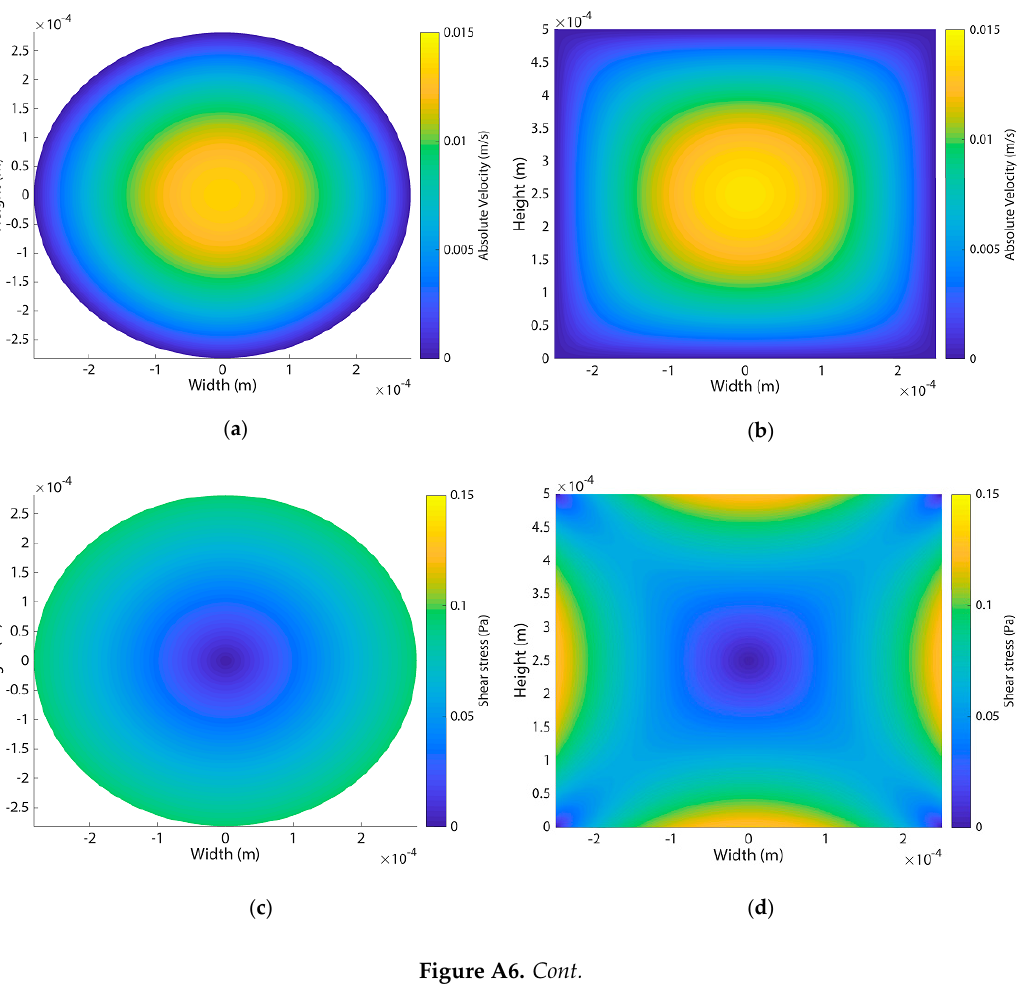
( f ) Figure A6. Comparison between circular and square cross-sectional channel with identical cross- sectional areas for velocity and shear stress: ( a ) Velocity field inside a circular cross-sectional channel showing an axial symmetry; ( b ) Velocity field inside a square cross-sectional channel, showing stagnation of the flow in the corners; ( c ) Shear stress profile inside a circular cross-sectional channel. The shear stress is constant along the wall and independent of position; ( d ) Shear stress profile inside a square cross-sectional channel. The shear stress shows a flattened parabolic profile along the walls with vanishing shear stress in the corners; ( e ) Probability density function of velocities inside a